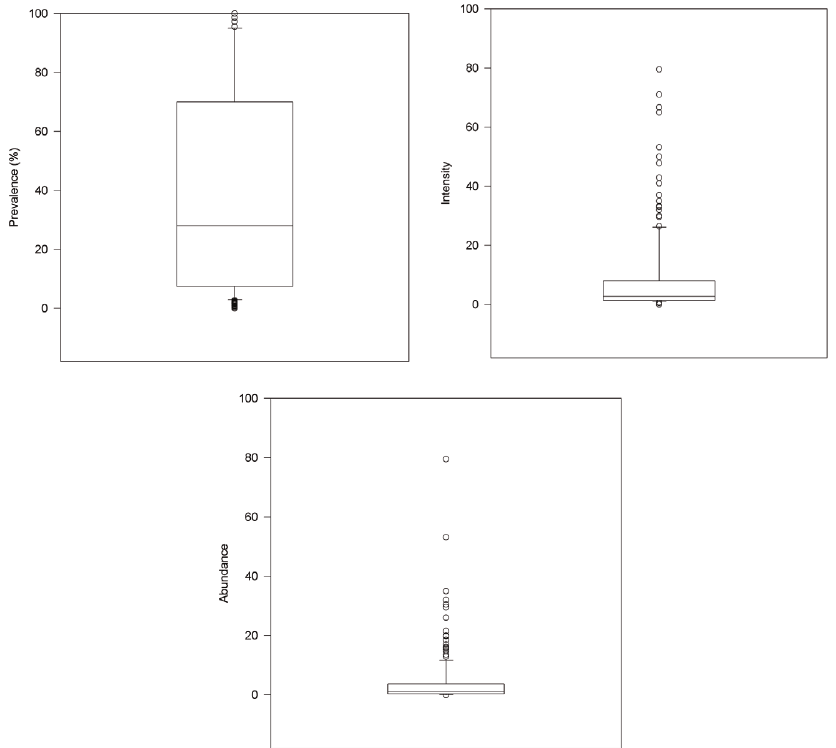
Figure 3. Quantitative descriptors of infestation for Caligus species in samples of teleost species (Box plots represent medians, percentile ranges (25-75%), minimum- maximum and outlier